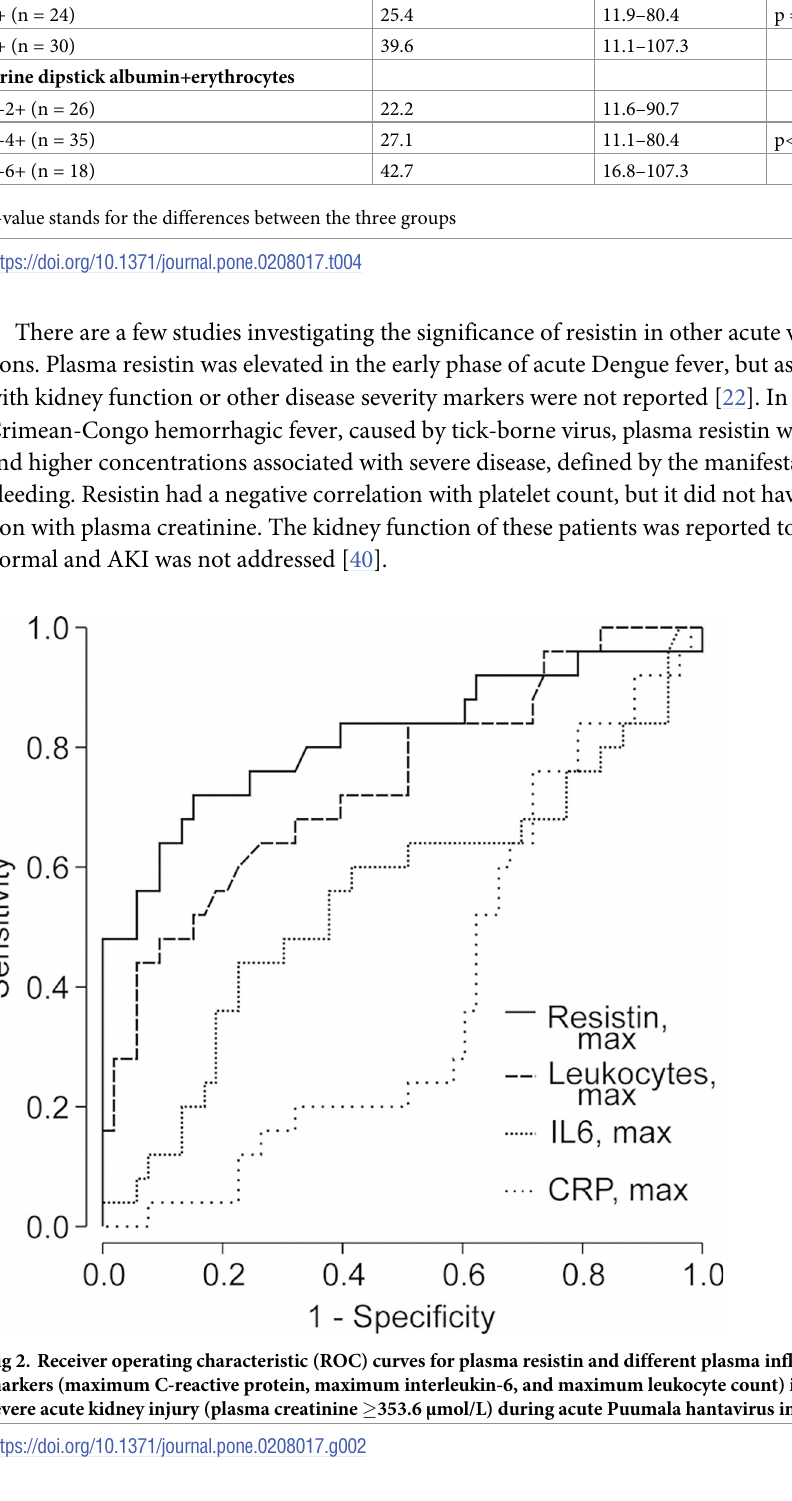
Table 4. Plasma resistin levels in different categories of urine dipstick albuminuria and hematuria in 79 patients with Puumala hantavirus infection. Urine dipstick albumin Resistin max median (pg/mL)